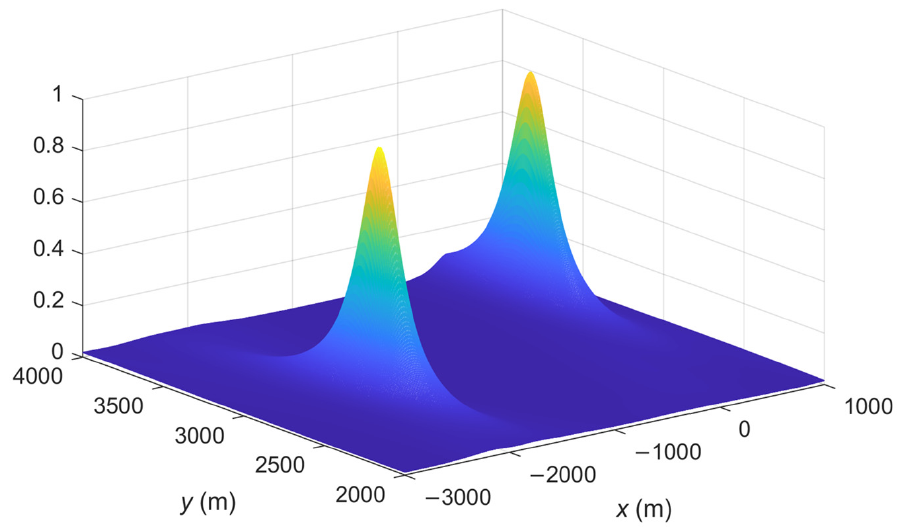
Figure 2. Spatial spectrum of ML_AOA/TOA (stereogram).